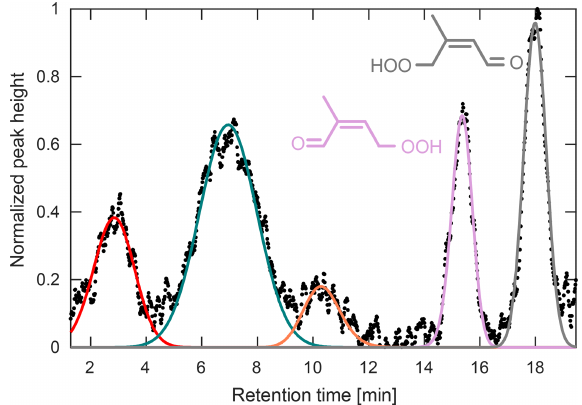
Figure 10. Chromatogram obtained during the PROPHET cam- paign for m/z 201. The latter two peaks have been identified pre- viously as the two HPALD isomers (Teng et al., 2017). The three early peaks remain unidentified. GC signal has been normalized to the largest peak